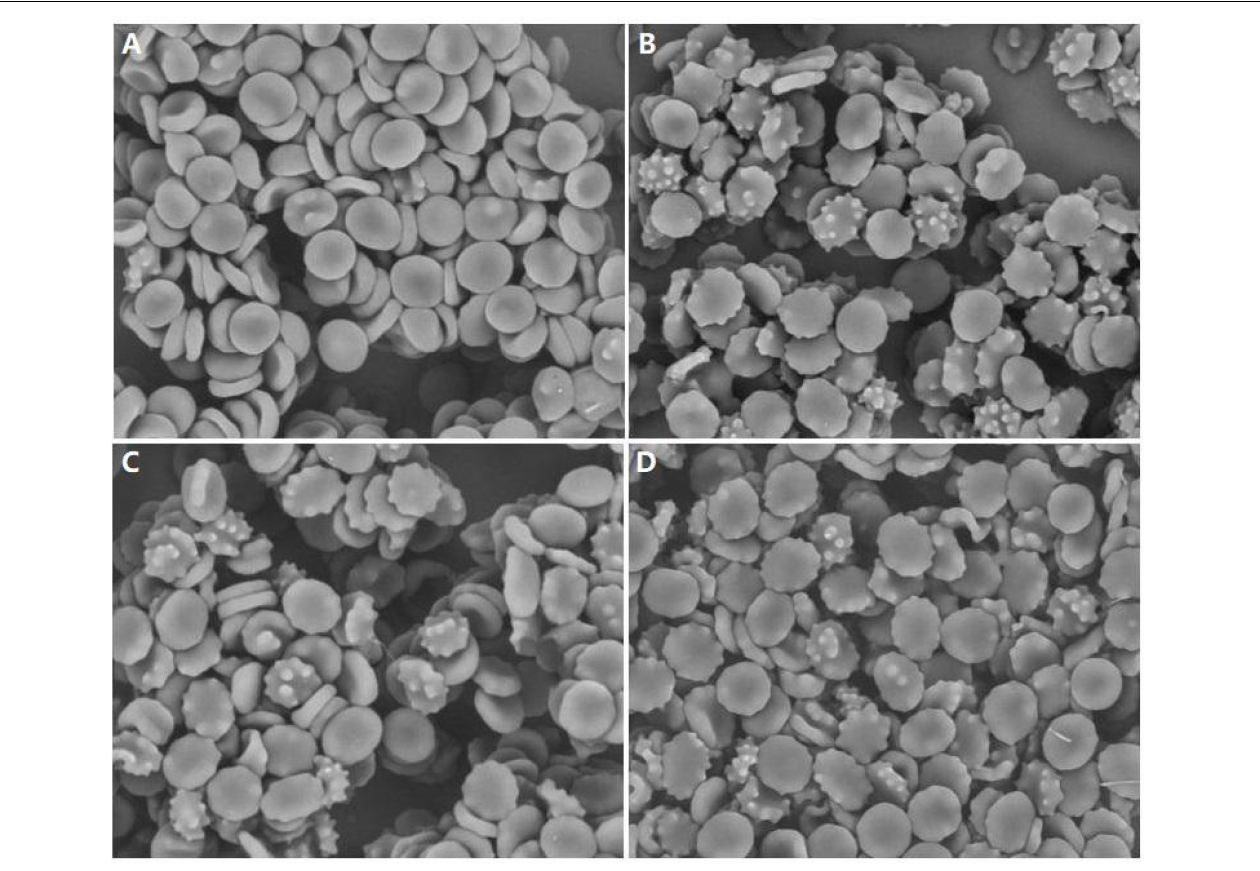
FIGURE 1 | Examination of peripheral blood of our patients by scanning electron microscopy showing acanthocytosis. (A) Patient 1, (B) Patient 2, (C) Patient 3, (D) Patient 4, magnification: ×